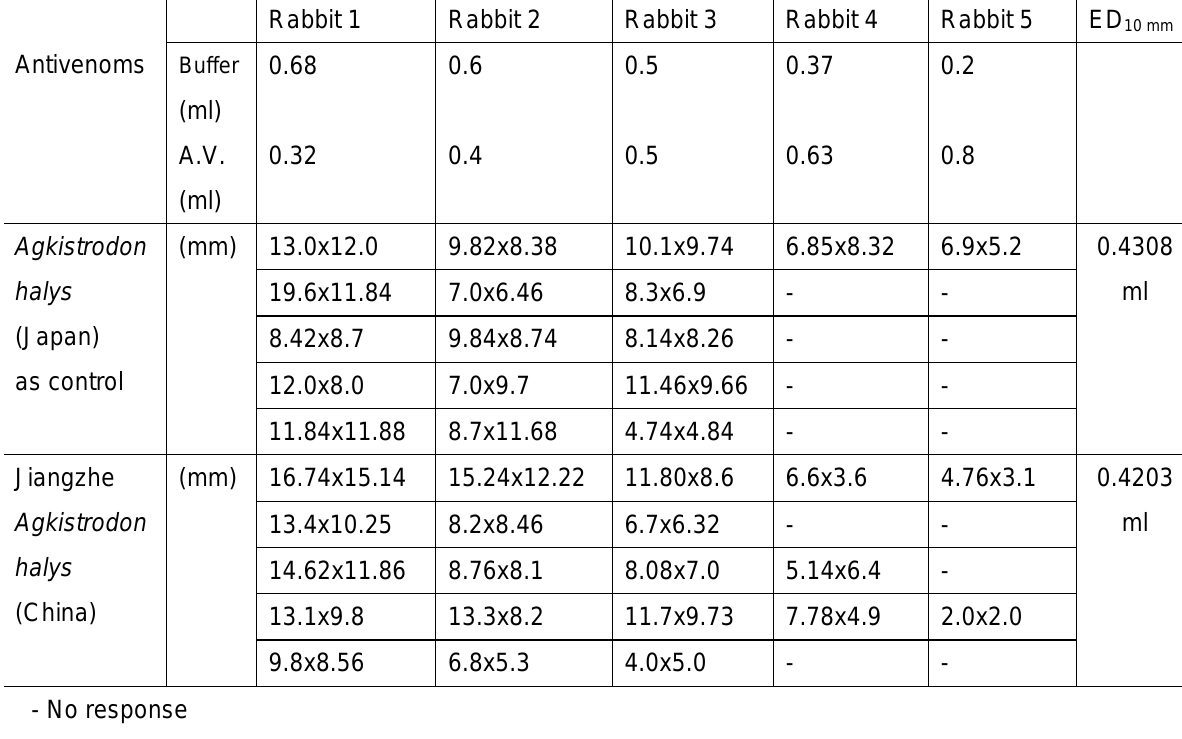
Table 8: Antihemorrhagic toxin titers of Agkistrodon halys and Jiangzhe Agkistrodon halys antivenoms against 83 µg-leveled Agkistrodon halys